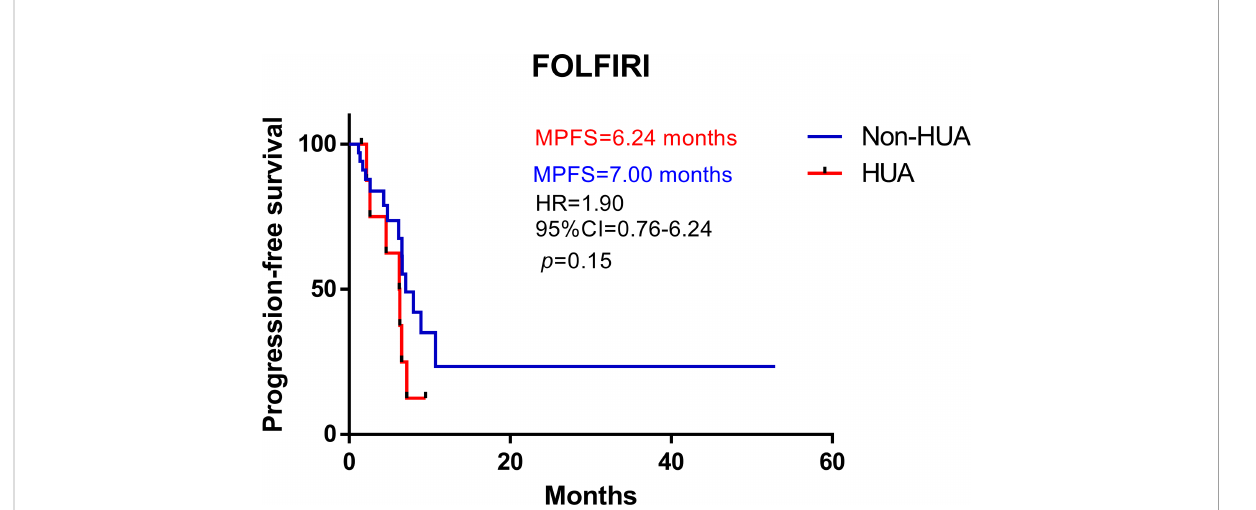
FIGURE 3 Kaplan-Meier plots comparing the PFS of the different baseline SUA level CRC patients treated with FOLFIRI. HUA, high uric acid, Non-HUA, non-high uric acid, MPFS, median